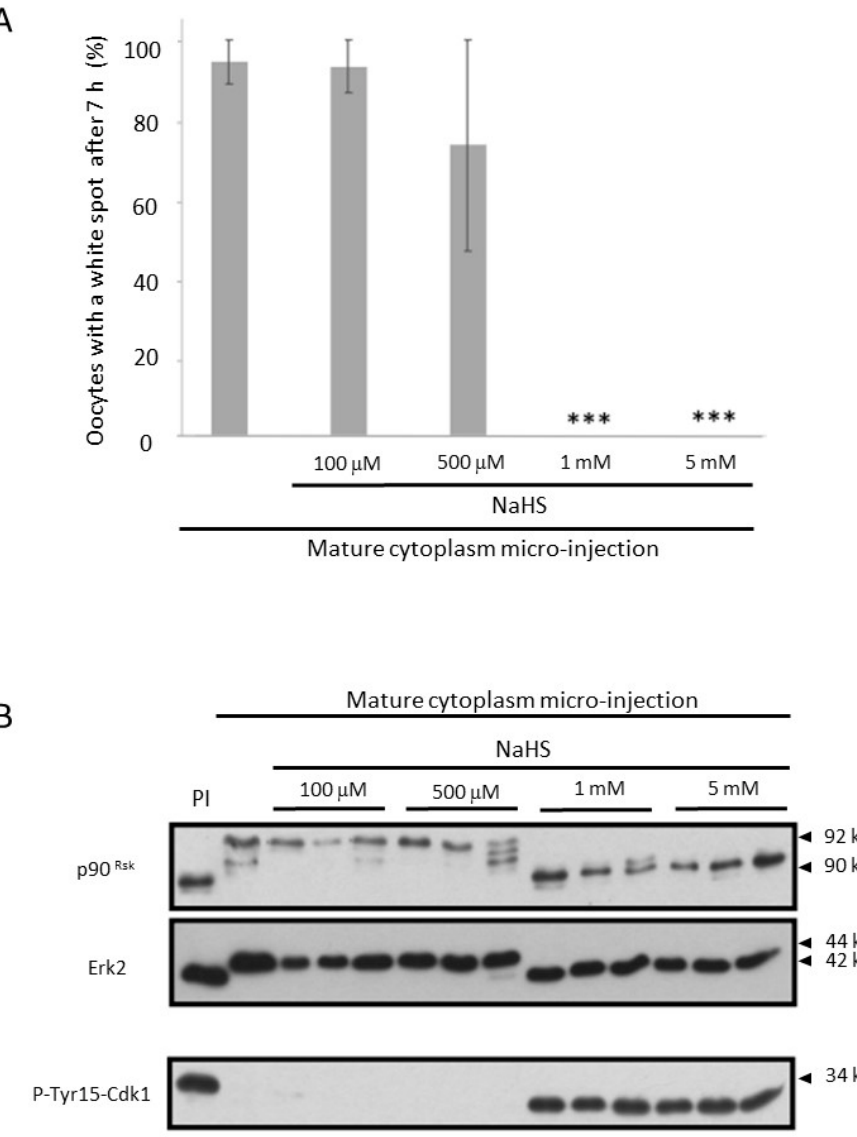
Figure 5. High concentrations of NaHS inhibit meiosis resumption induced by micro-injection of mature oocyte cytoplasm. Immature oocytes were pre-incubated (or not) in NaHS at di ff erent concentrations for 1 h before microinjection of mature cytoplasms. Some oocytes were maintained in culture medium without treatment (PI). ( A ) Percentage of oocytes exhibiting a white spot 7 h after micro-injection of mature oocyte cytoplasm. Statistical significance was accepted for *** p < 0.001. N = 3; n = 15 ( B ) Western blot analysis of p90 Rsk , Erk2, and P-Tyr15-Cdk1 for three oocytes / NaHS conditions. Seven hours after micro-injection, oocytes were individually analyzed by Western blotting. Two populations were discriminated: oocytes remaining in prophase I and oocytes in metaphase